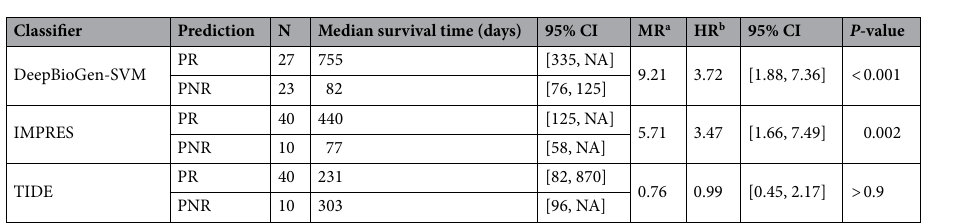
Table 2. Summary statistics for progression-free survival analysis. a Median ratio. b Hazard